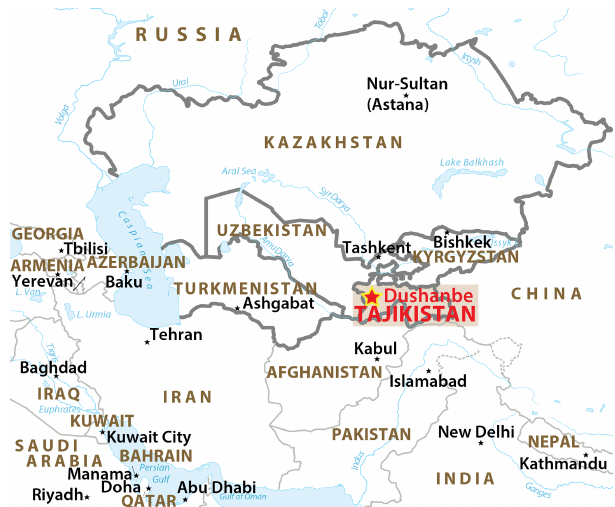
Figure 1. The five countries defining Central Asia (within the thick boundaries). Highlighted is the lidar station (red star) at Dushanbe, Tajikistan. (http://www.shadedrelief.com/political/ Political_Map_Pat.pdf, last access: 15 October 2019 ©Tom Patter- son,